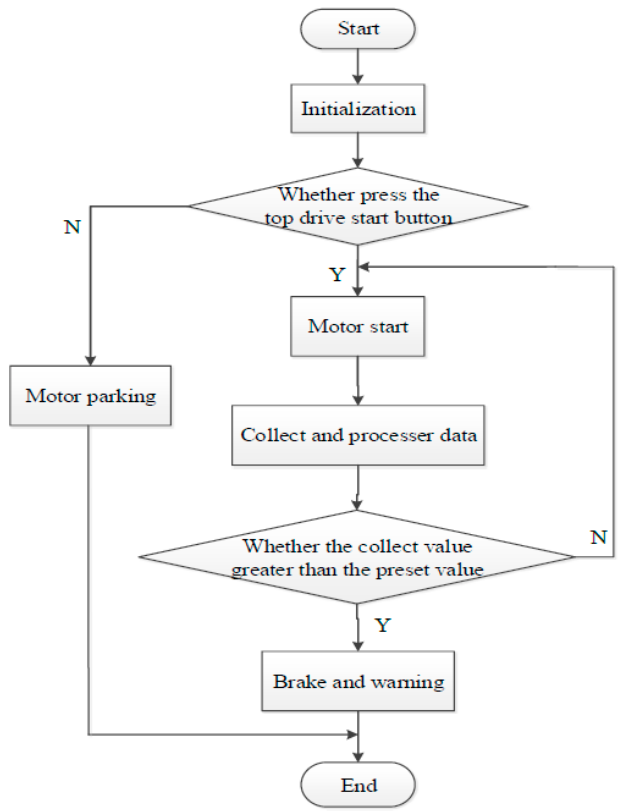
Figure 9. Program flow chart of top drive.